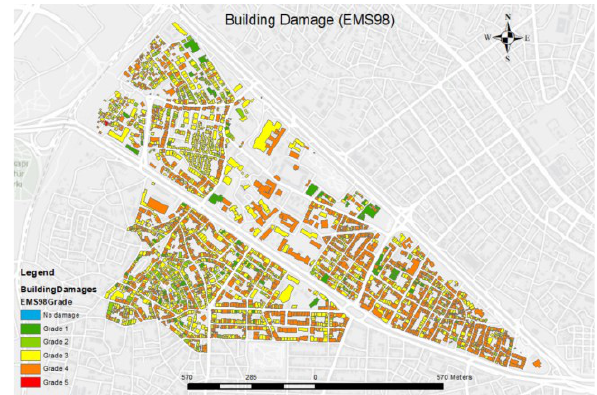
Figure 8 . Building damage grades. Source: de Vries, 2022